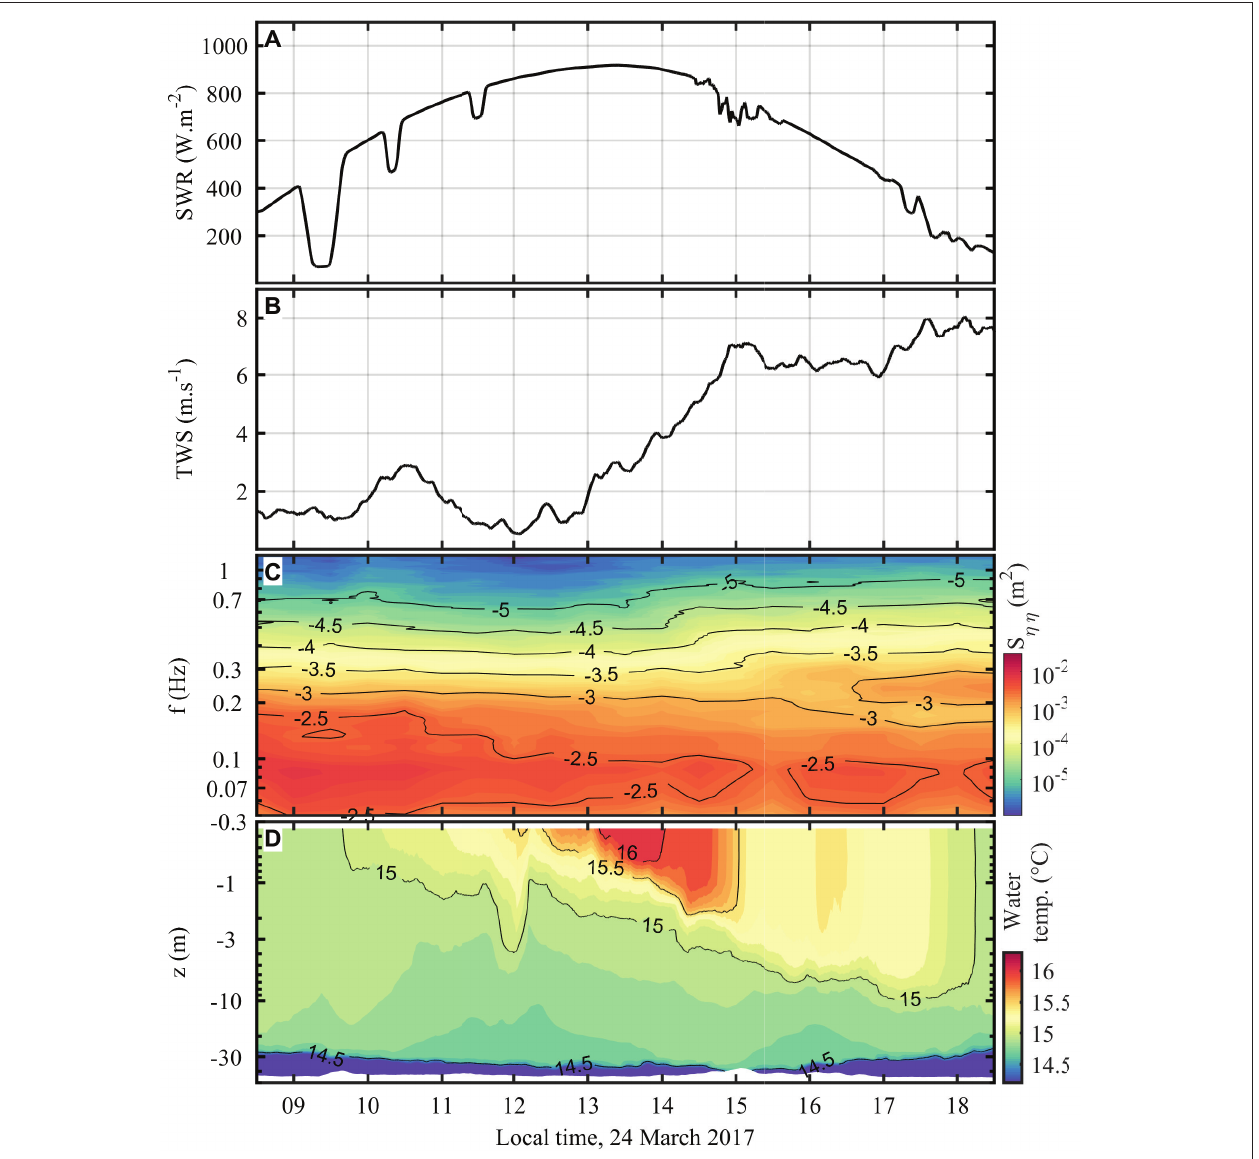
FIGURE 11 | Ten-hours evolution of (A) the short-wave solar radiation SWR, (B) the true wind speed TWS, (C) the wave field spectrogram, and (D) the water temperature during LCDRI2017 starting at 0830 PDT 24 March 2017. Solar radiation was measured from the R/P FLIP while wind, waves, and water temperatures were measured by the SV2 Wave Glider Kelvin . In the morning when the wind was low, the heat from the incoming solar radiation was stored in a very thin layer beneath the interface. As soon as the wind increased, short wind-waves developed leading to enhanced mixing through direct mechanisms such as wave breaking or via indirect mechanisms such as Langmuir circulation. The surface heat content was then quickly mixed downward, leading to an increase of the water temperature throughout the ocean mixed layer.